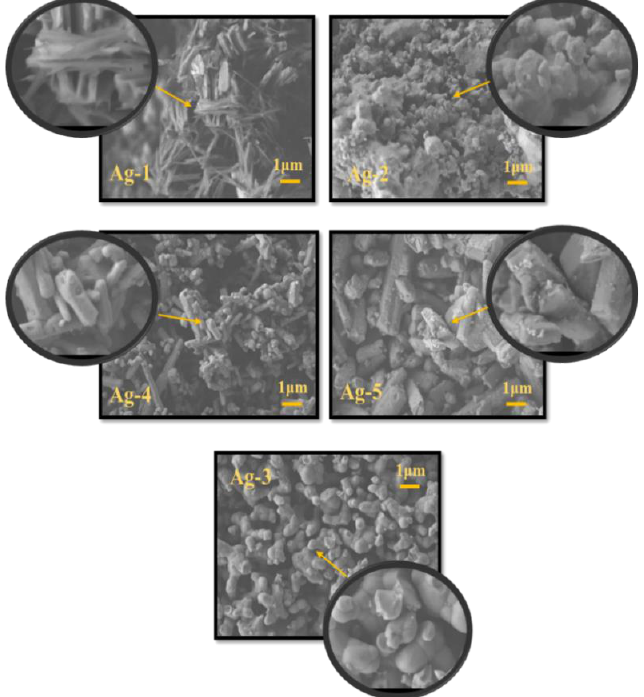
Figure 2. SEM images of synthesized Ag-containing nanomaterials . Table 1. Data obtained from XRD, SEM, DR UV- vis , and N 2 -physisorption analyses.